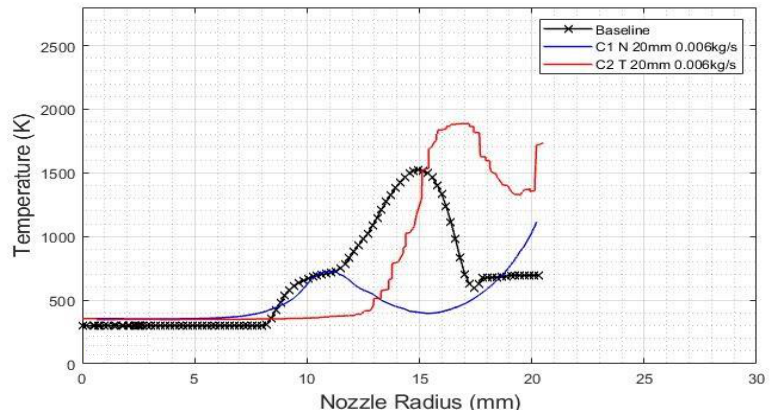
Figure 7. Static temperature vs. nozzle radius for C1 and C2.